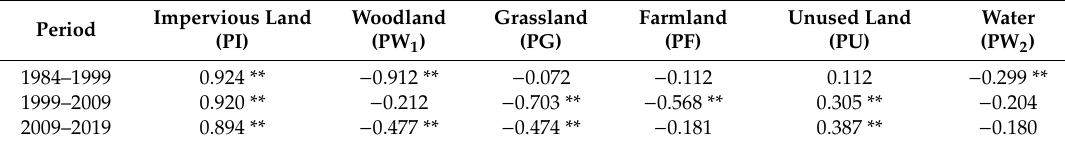
Table 4. Spearman correlation coefficients between surface runoff change and land use change under the rainfall return period of 100a.